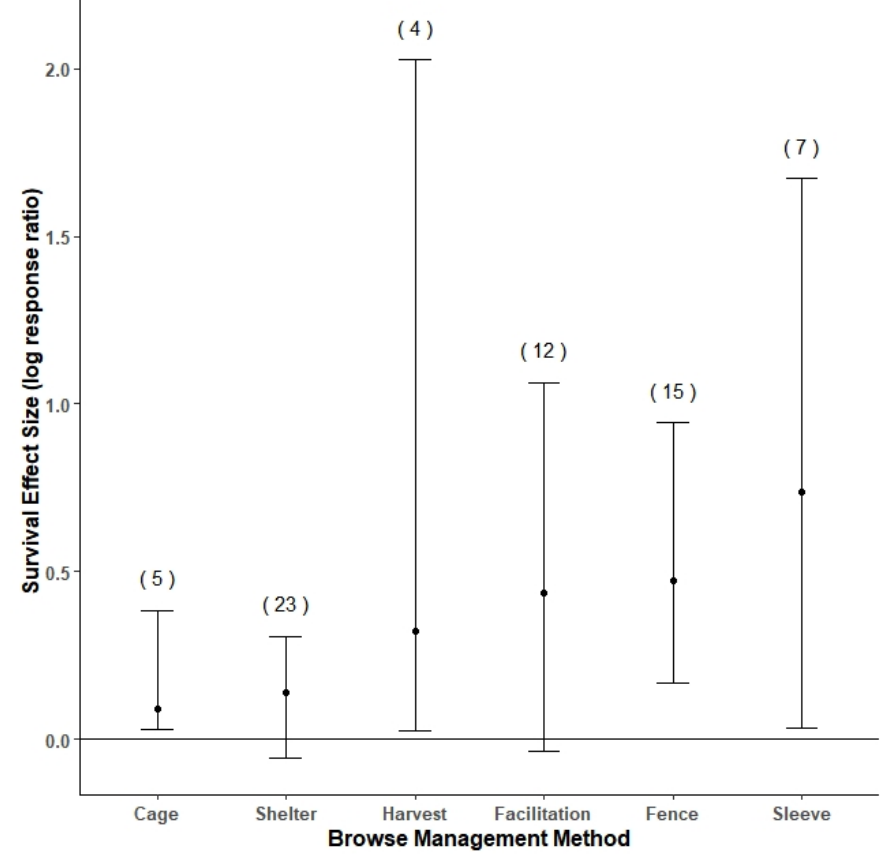
Figure 3. Mean and 95% confidence limits of survival effect size (log response ratio) among seven categories of browse management. Numbers in parentheses represent the number of studies used for each method.